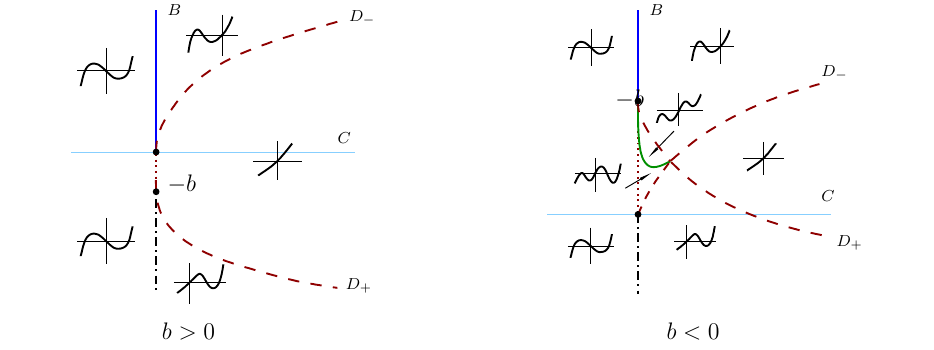
Figure 24 . Effective potential for Case I: A > 0 , A + a > 0 .